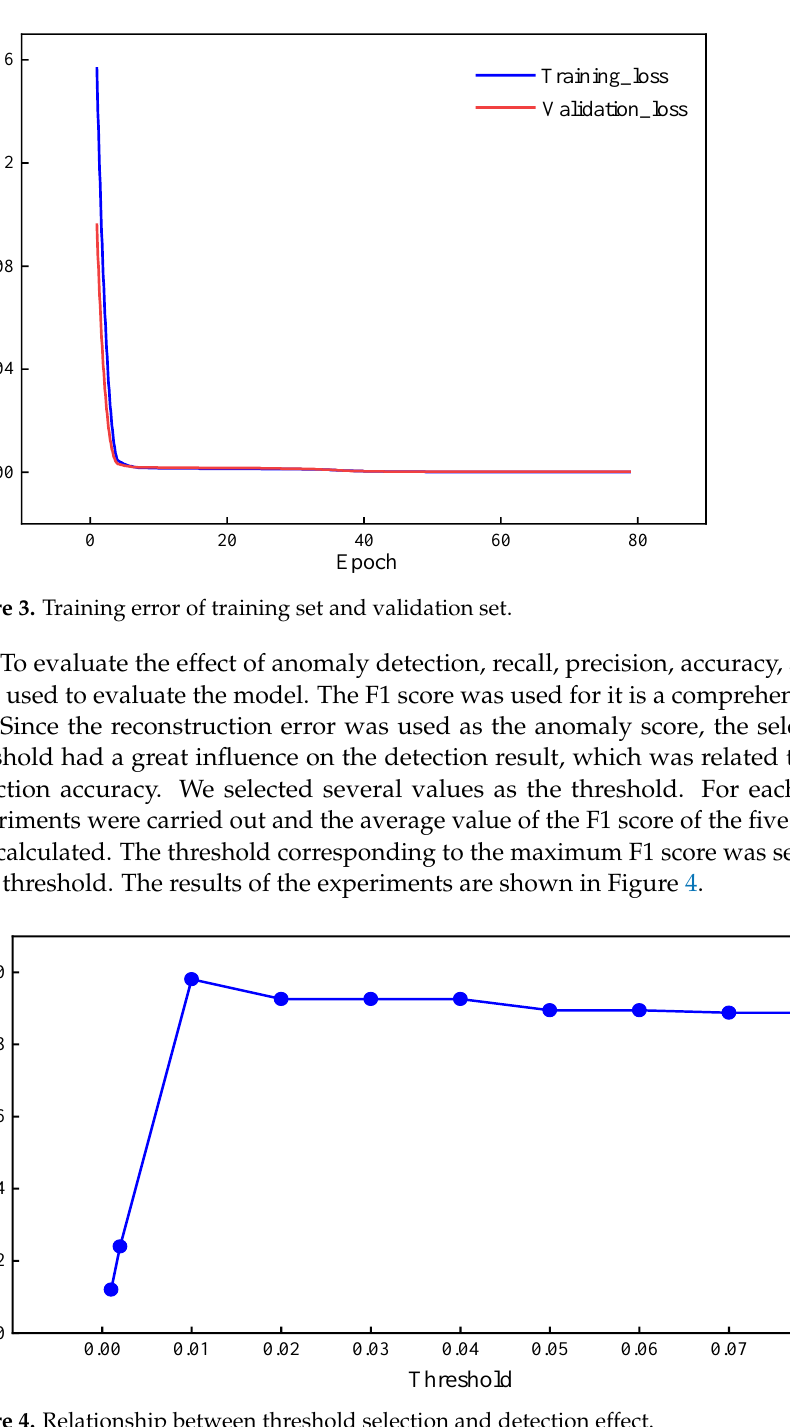
Figure 4. Relationship between threshold selection and detection effect.